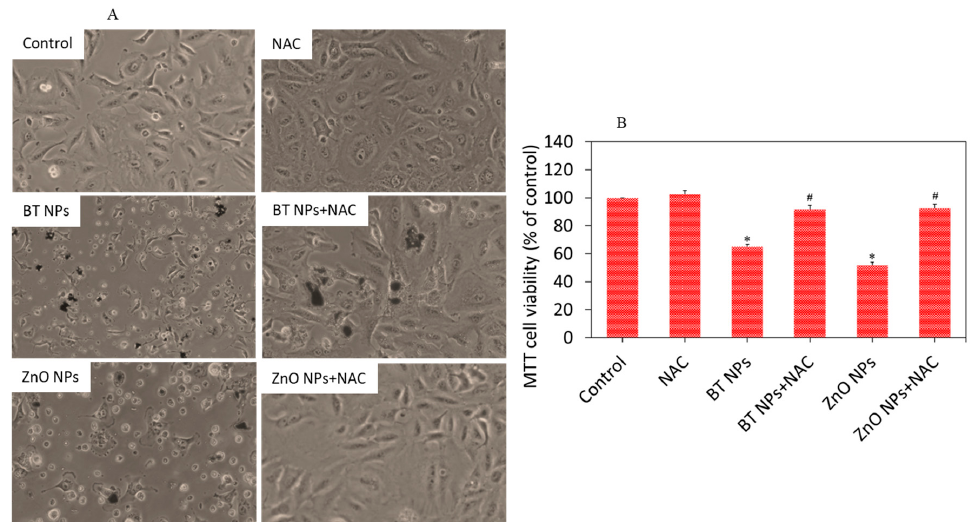
Figure 7. BT NP-induced cytotoxicity was mediated through oxidative stress. Cells were exposed for 24 h to 50 µg/mL of BT NPs with or without NAC (2 mM). ZnO NPs (25 µg/mL for 24 h) were used as a positive control. ( A ) Cell morphology. ( B ) MTT cell viability. * Indicates statistically significant difference from the control group ( p < 0.05). # Indicates that NAC effectively abrogated the cytotoxic effect of BT NPs or ZnO NPs.